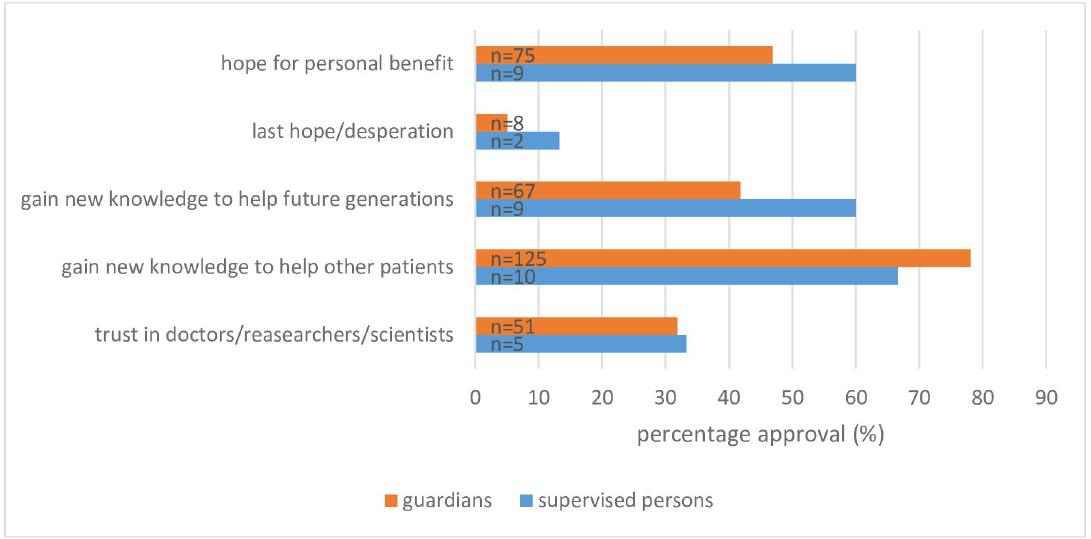
Fig 3. Reasons/motivations for agreeing to participate in a medical research project from the perspective of the guardians for each guardian-supervised patient-dyad separate (n = 160) and the supervised persons (n = 15). Multiple answers were possible.